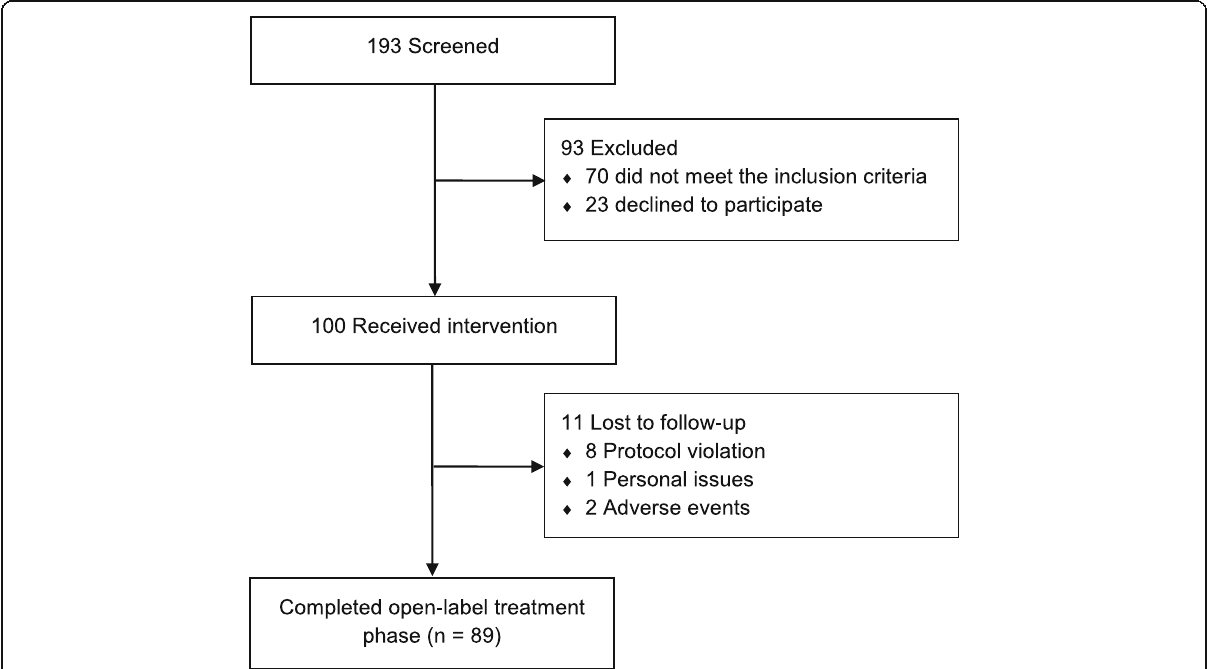
Fig. 1 Flow of Participants in an Open-Label Study of Erenumab for Prevention of Persistent Post-Traumatic Headache attributed to Mild Traumatic Brain